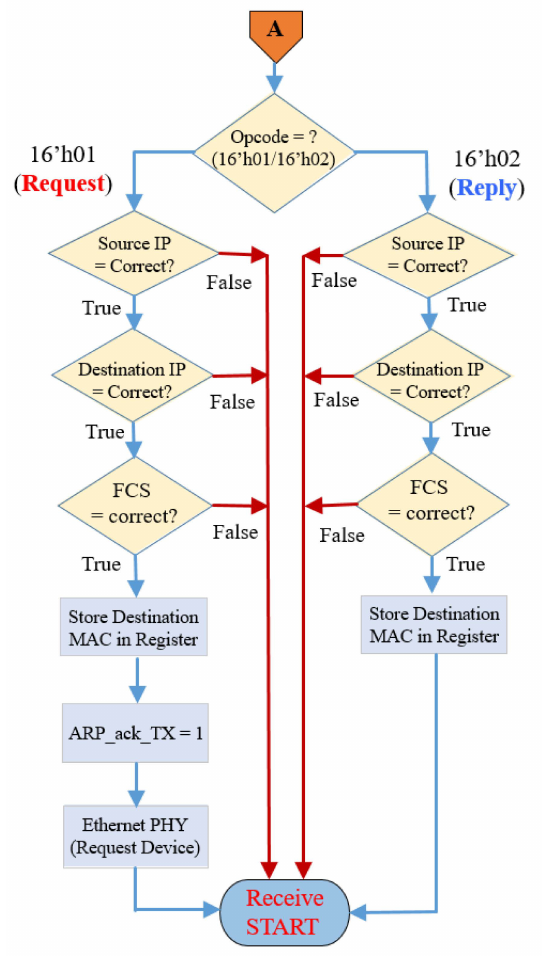
Figure 7. Flowchart of the ARP packet receiving process in the Ethernet